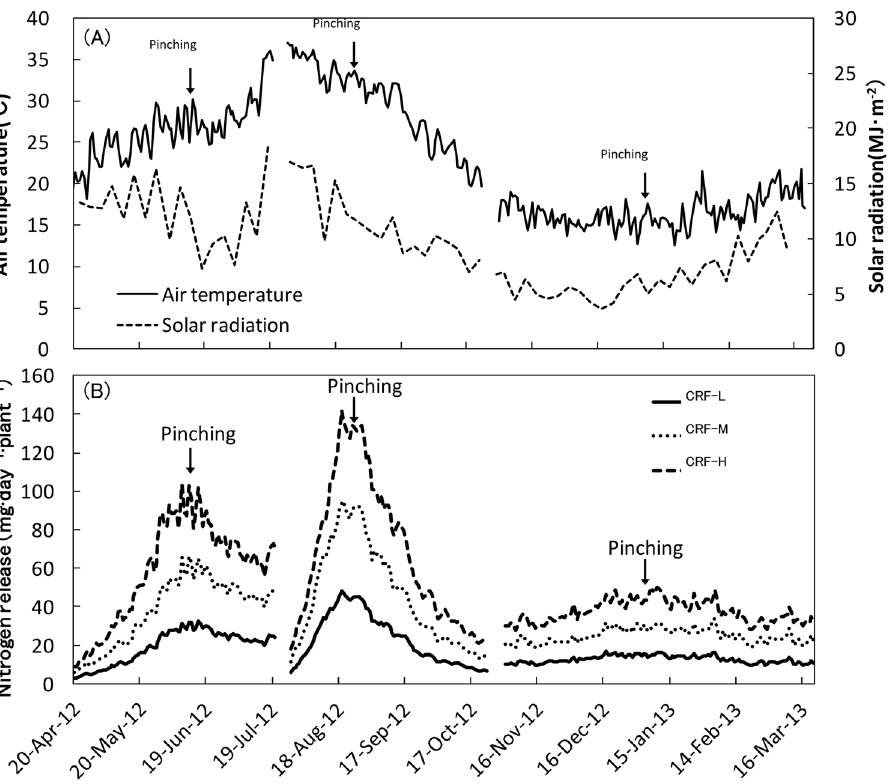
Figure 2. Mean daily air temperature and 5-day solar radiation inside the greenhouse (A) and daily nitrogen release rate from CRF (B) during each cropping season.